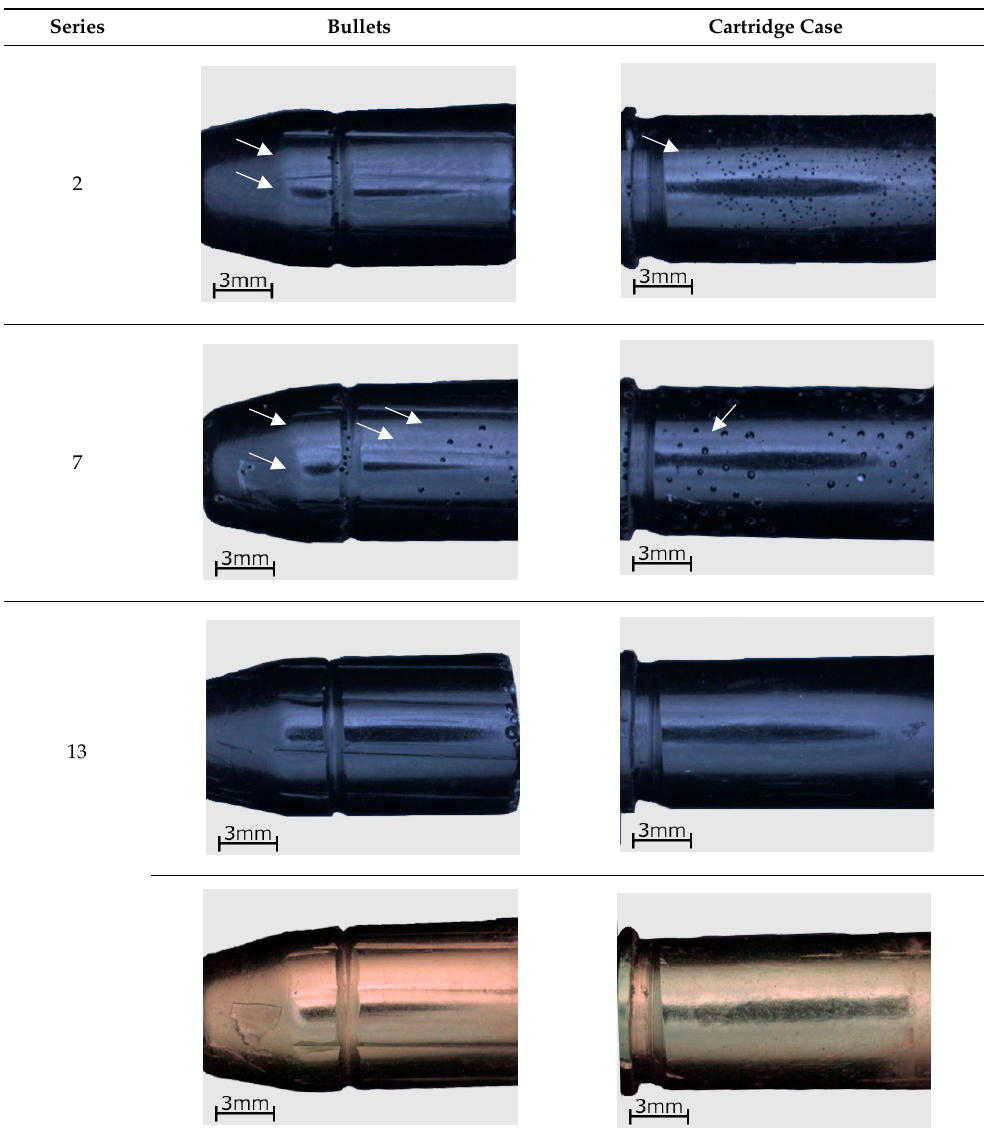
Table 6. Macroscopic images of external surfaces for selected representative series of case and bullet replicas. The arrows in the images indicate defects (pores) on the specimen surfaces. In the case of series 13, the images also show specimens with PVD coatings.